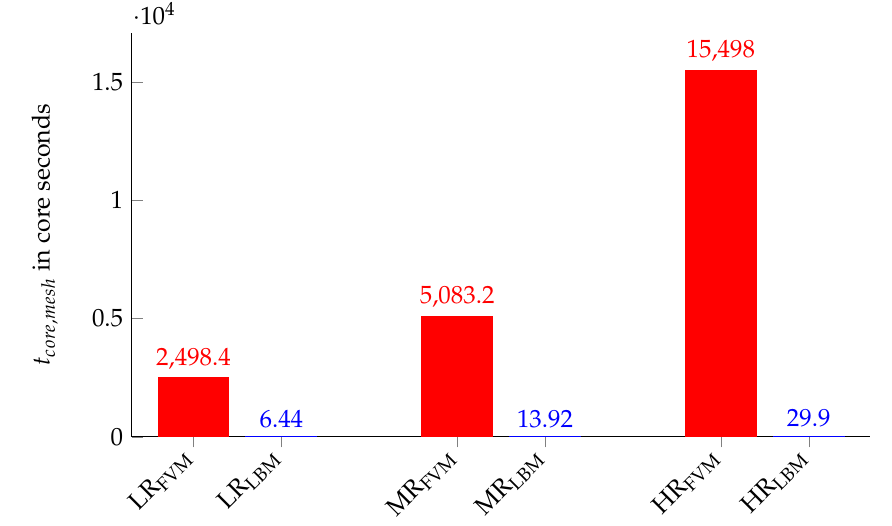
Figure 13. Meshing runtime t core , mesh comparison between OpenFOAM and OpenLB for the three grid configurations: LR, MR and